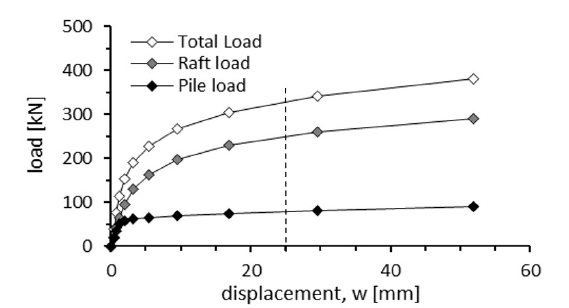
Figure 13. Load-settlement curves for case 6 - L=4m;